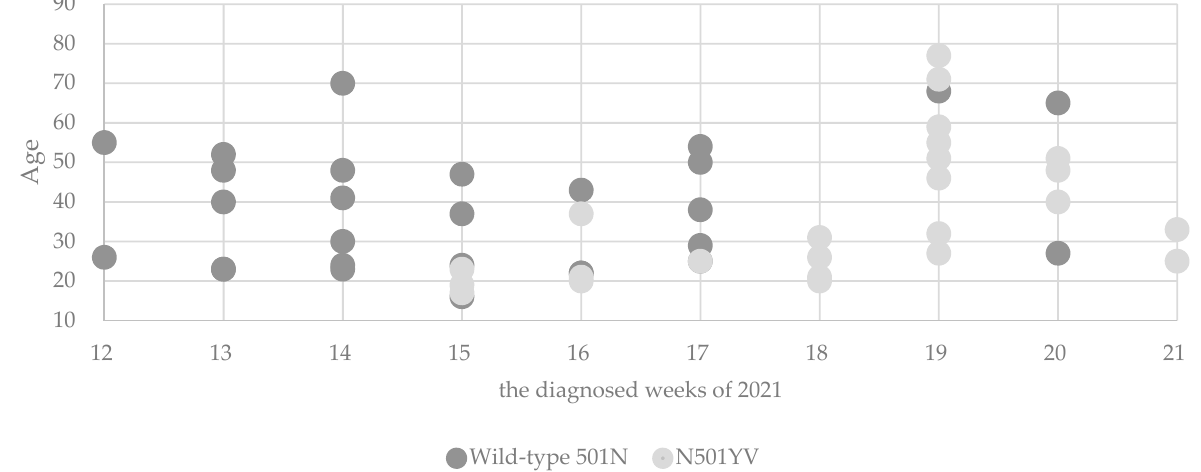
Figure 3. Age distribution of COVID-19 patients per week.